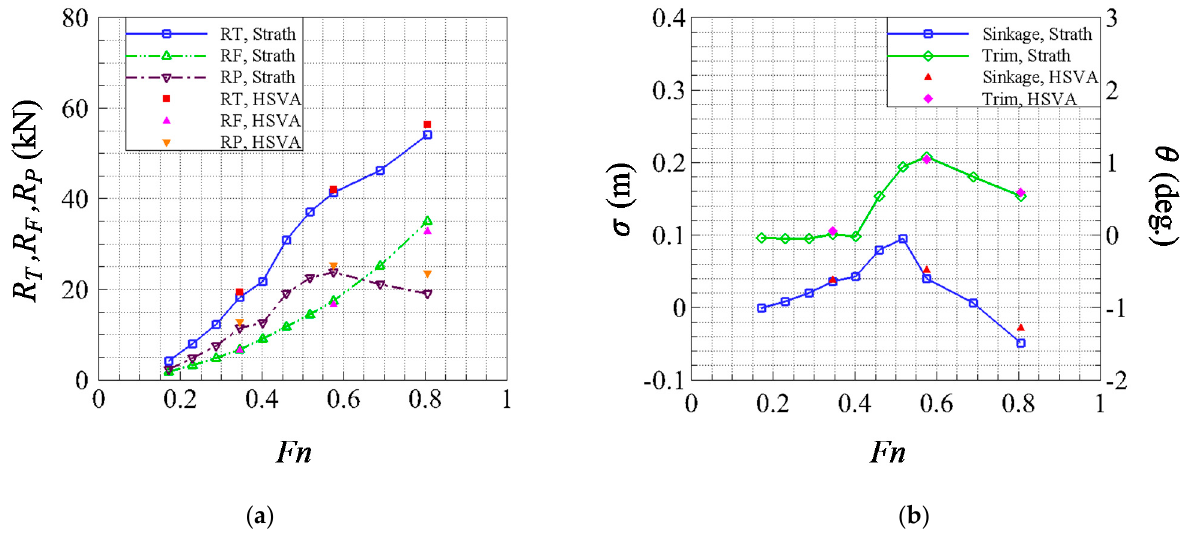
Figure 7. Resistances ( a ) and motions ( b ) of the London Demonstrator in deep water.